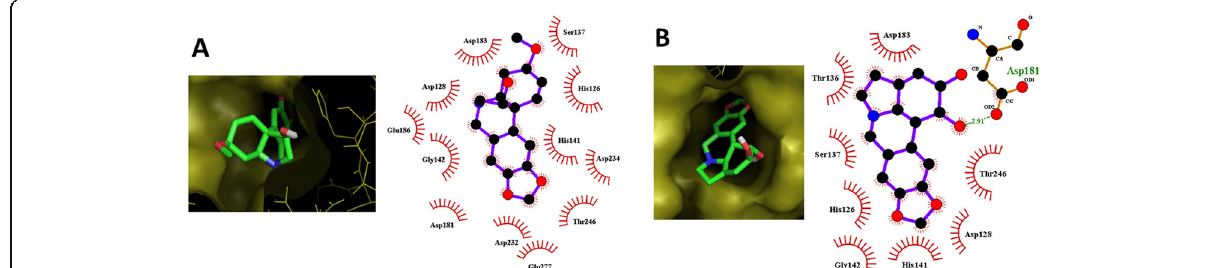
Fig. 7 The binding configuration of C. glaucum phytoconstituents and interaction analysis. Binding poses of a Crinamine and b Lycorine on arginase I active site as obtained from molecular docking using AutoDock Vina. Result of 2D interaction analysis shows hydrogen bond (green dashed lines) and hydrophobic interaction (red curved lines) using LigPlot